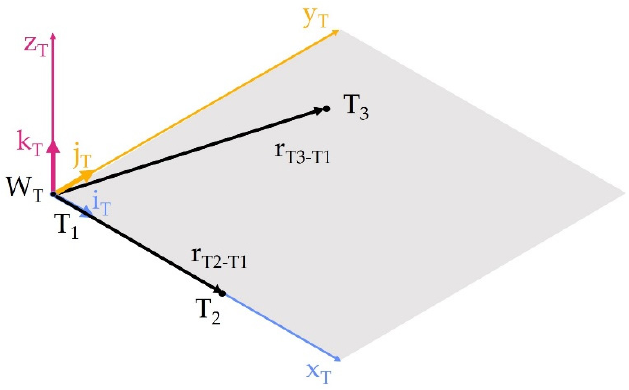
Figure 8. Determination of the W T coordinate system.